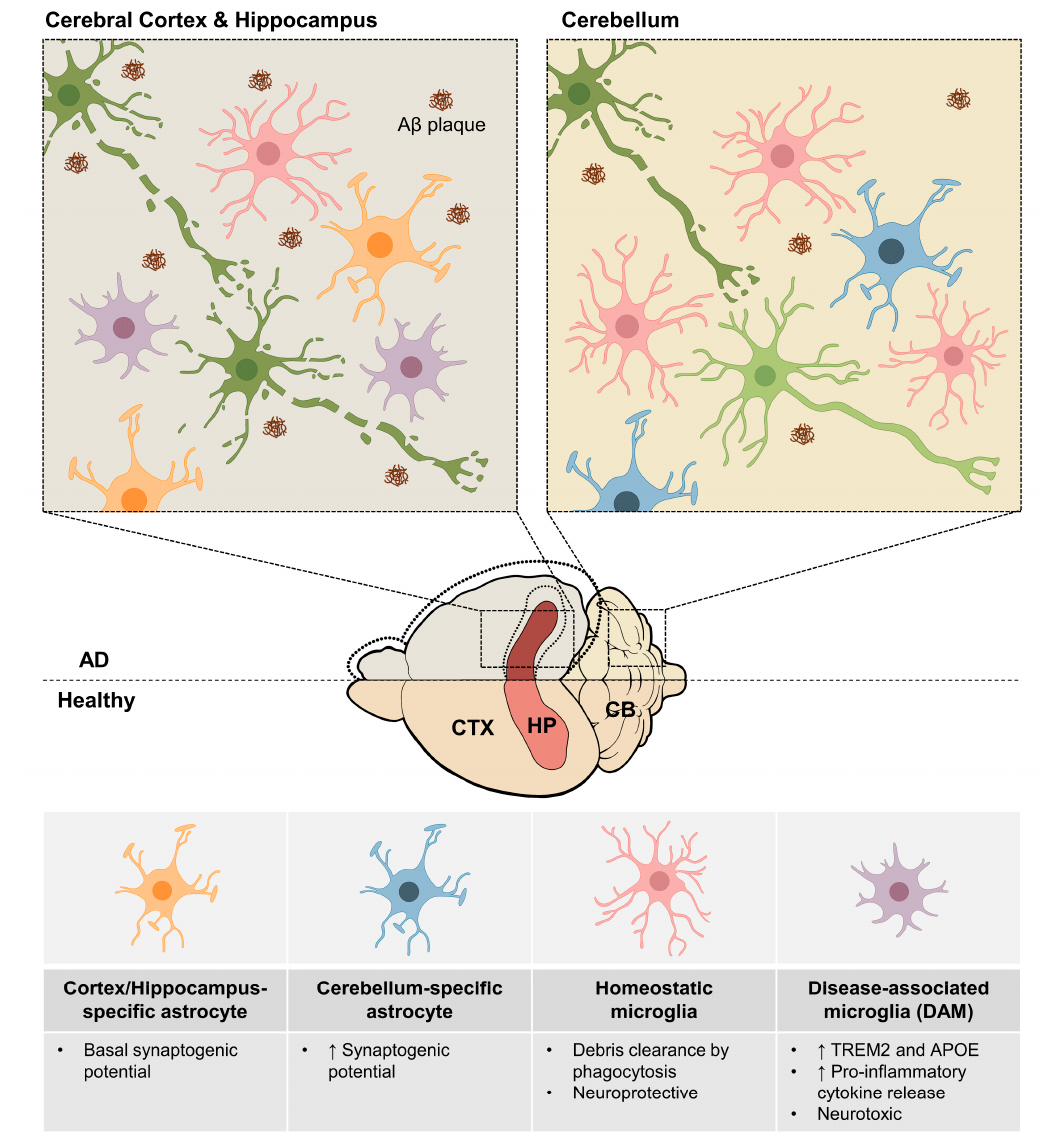
Figure 4. Regional heterogeneity of astrocytes and microglia during Alzheimer’s disease. During Alzheimer’s disease (AD), the volume of cerebral cortex and hippocampus tends to decrease due to neurodegeneration, while the volume of cerebellum shows minor changes (shown through dotted line). This discrepancy in the degree of neurodegeneration between cortex/hippocampus and cerebellum comes from the differences in the population of astrocytes and microglia in three regions. While the cortex/hippocampus-specific astrocytes (orange) show basal synaptogenic potential, the cerebellum-specific astrocytes (blue) show greater synaptogenic potential, which might prevent synaptic degeneration by amyloid β plaque (A β plaque, brown). With microglia, the number of homeostatic microglia (pink) with neuroprotective effect decreases in cortex and hippocampus, while the number does not change in the cerebellum. In addition, the disease-associated microglia (DAM, purple) with neurotoxic effect are only found in the cortex and hippocampus and not in the cerebellum. Thus, the degeneration of neuron happens at a greater degree in cortex and hippocampus when compared to cerebellum. CTX: cerebral cortex; HP: hippocampus; CB: cerebellum; ↑ : increased. Region-specific astrocytes may also be induced by the region-specific pathogenesis of AD. NFTs, formed by the accumulation of hyper-phosphorylated tau, are initiated in the entorhinal cortex and gradually spread to the hippocampus and other regions of the